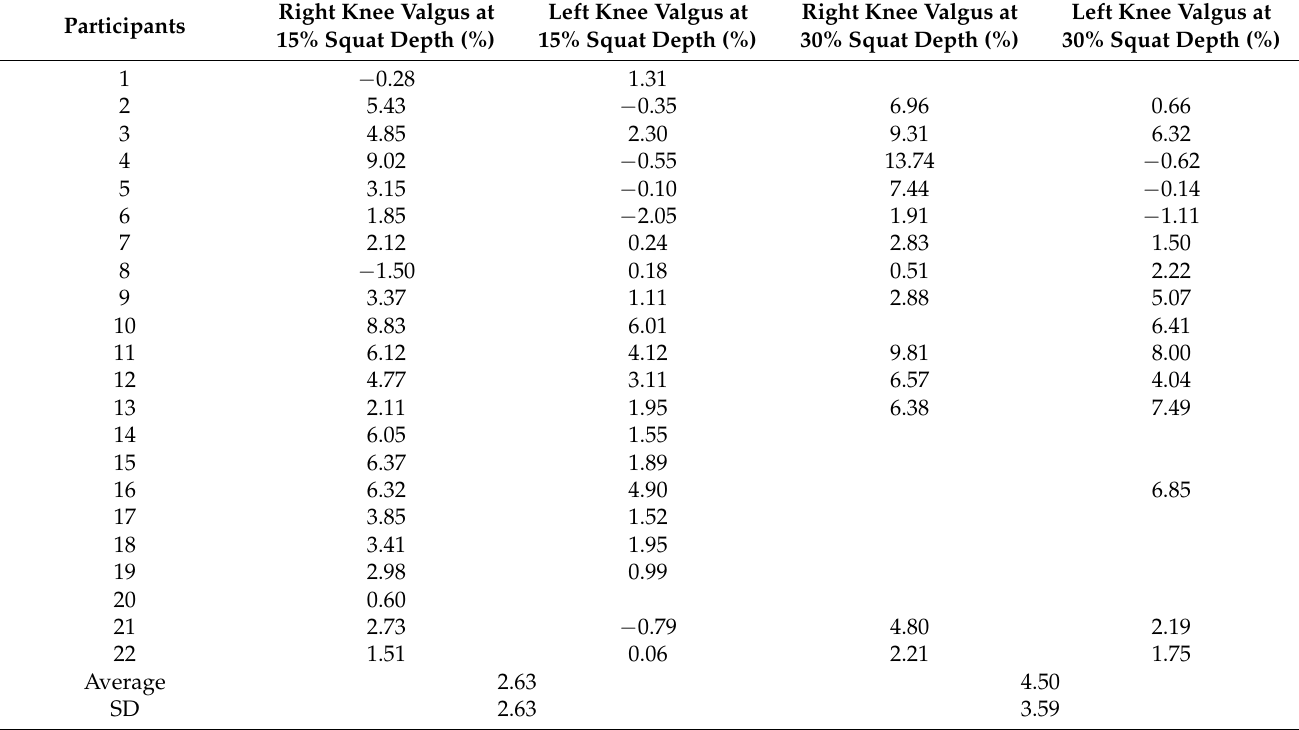
Figure 4. Representative recordings of single-leg squats vs. squat depth in six subjects. Panels ( A – F ) show three male and three female subjects at exactly 15% squat depth; note that although the knee is only slightly bent, the valgus tendency is evident in those who are prone to this deviation ( B , C , F ). Panel ( G ) shows the valgus shift vs. squat depth plot of these individuals; letters on the curves correspond to the image shown. Squat depth is measured on the horizontal axis, and knee deviation on the vertical; the lines that are not continuous indicate that the subject didn’t reach the maximum squat depth at 30%. Vertical dotted lines show the 15% depth mark, where the valgus or stable tendencies can already be observed. Panel ( H ) shows the distribution of valgus shift at 15% and 30 squat depths in 44 knees. The line represents the median. Table 2. Knee valgus values of subjects.